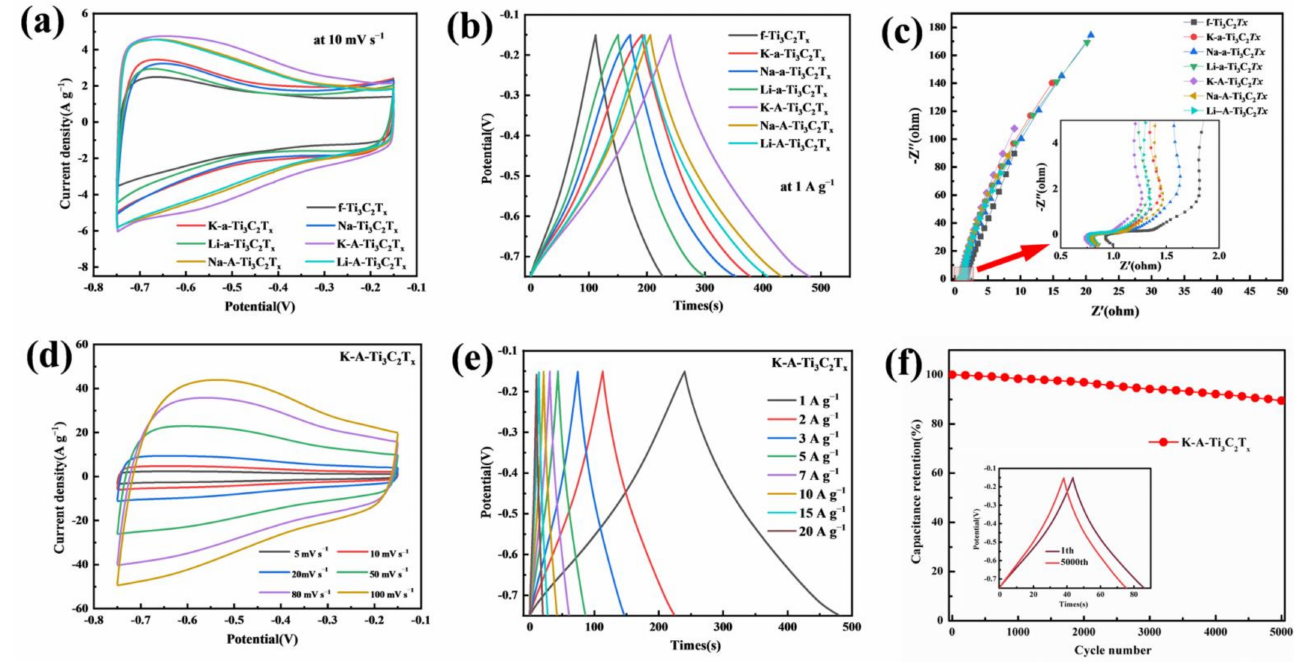
Figure 8. ( a ) CV curves of the Ti 3 C 2 T x electrodes at the scan rate of 10 mV s − 1 , ( b ) GCD profiles of the Ti 3 C 2 T x electrodes at the scan rate of 1 A g − 1 , ( c ) Electrochemical impedance spectroscopy data of the Ti 3 C 2 T x electrodes, ( d ) CV curves of the K-A-Ti 3 C 2 T x electrode at the scan rates of 10–100 mV s − 1 , ( e ) GCD profiles of the K-A-Ti 3 C 2 T x electrode at the scan rates of 1–20 A g − 1 , and ( f ) Cyclic stability of the K-A-Ti 3 C 2 T x electrode at a current density of 5 A g − 1